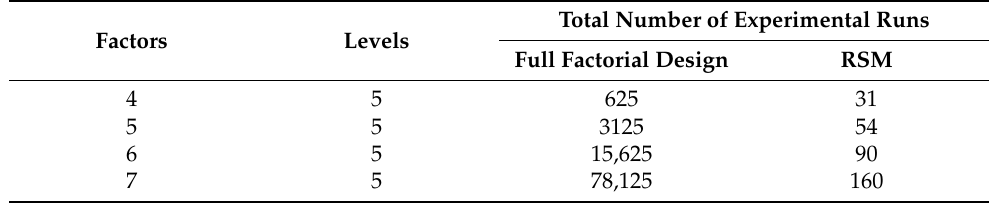
Table 1. Total number of experimental runs for full factorial design and RSM based on 5-level